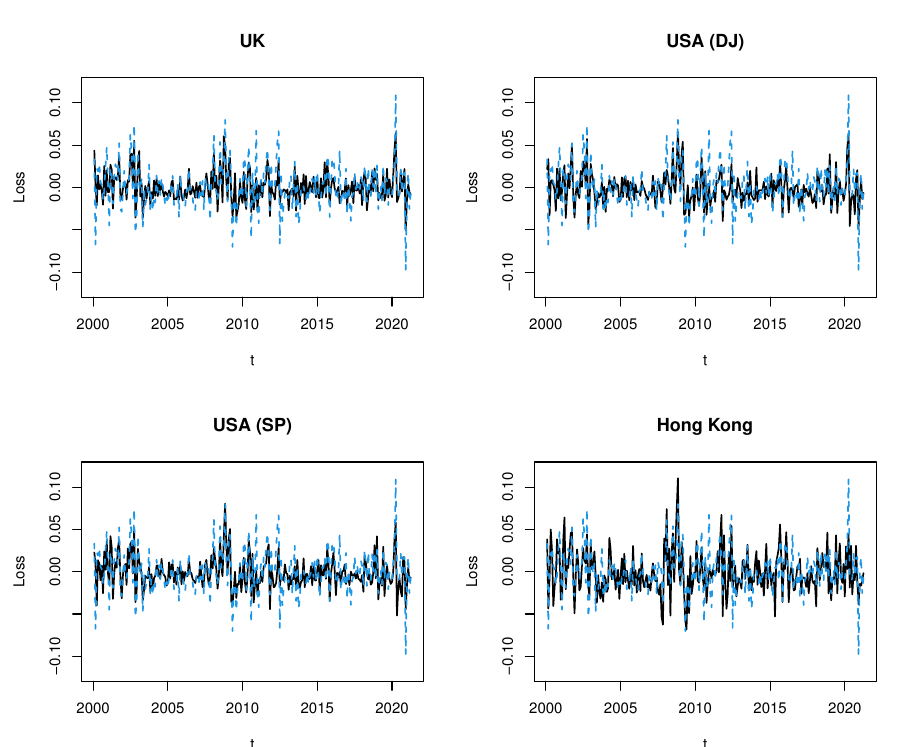
Figure 2. Losses of Spanish stock market index (dashed line in blue) and stock market indexes of four countries outside of the European Union (solid line in black).